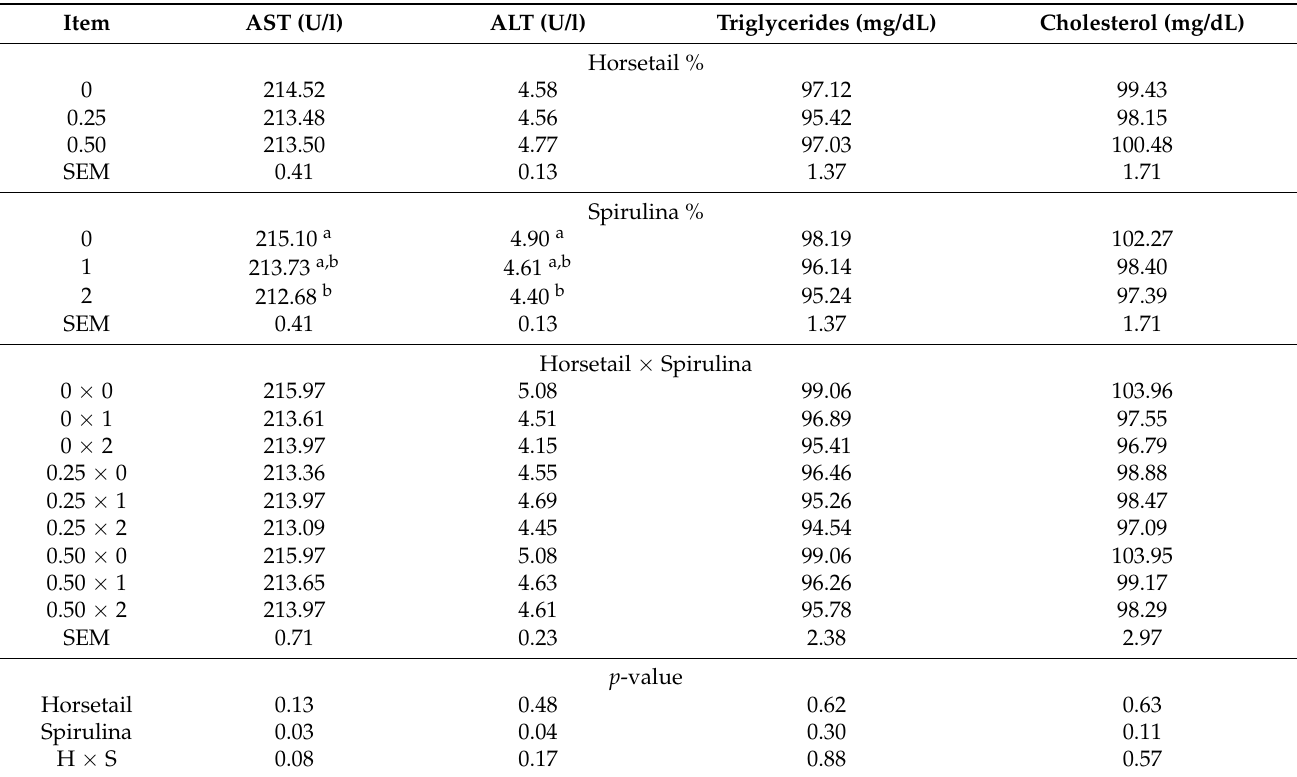
Table 7. Influence of diets on blood